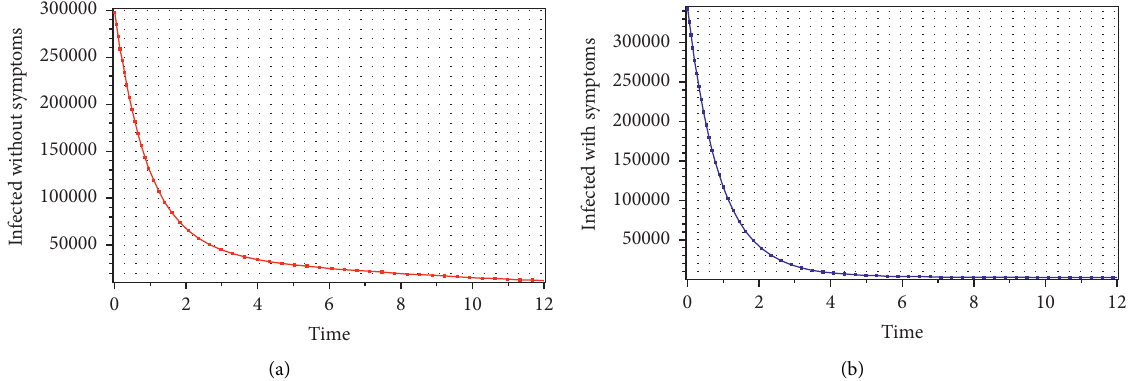
Figure 5: Diagram showing the (a) asymptomatic and (b) symptomatic infections predicted by the SEIR model.